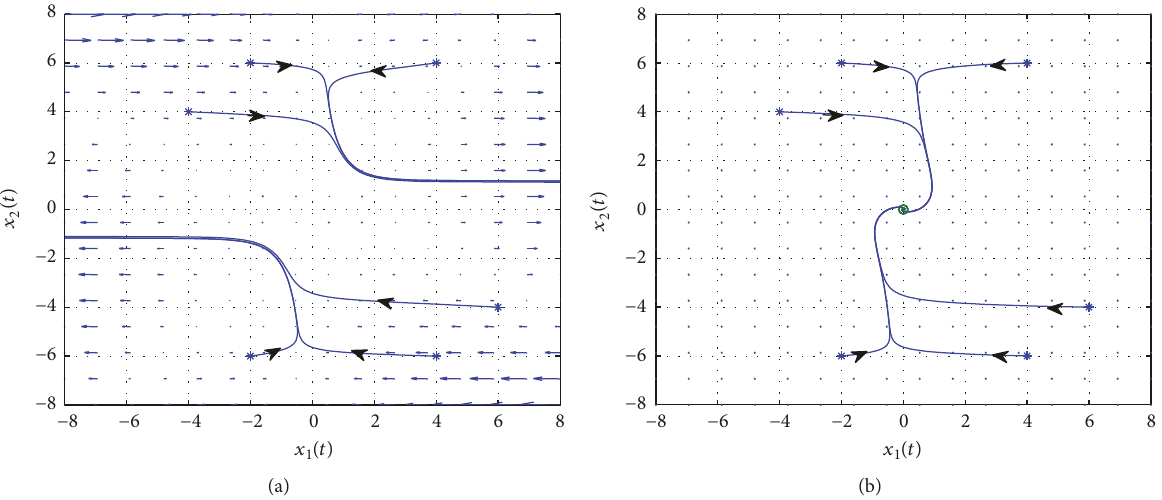
Figure 3: Behaviors of nonlinear system (52) in 𝑥 1 − 𝑥 2 plane. (a) depicts the movement trajectories of system (52) with 𝑢 = 0 for the initial points of (4,6) , (−2,6) , (−4,4) , (−2,−6) , (4,−6) , and (6, −4) and corresponding movement directions represented by arrows; (b) shows the behaviors of system (52) with control input for the same initial points as (a).